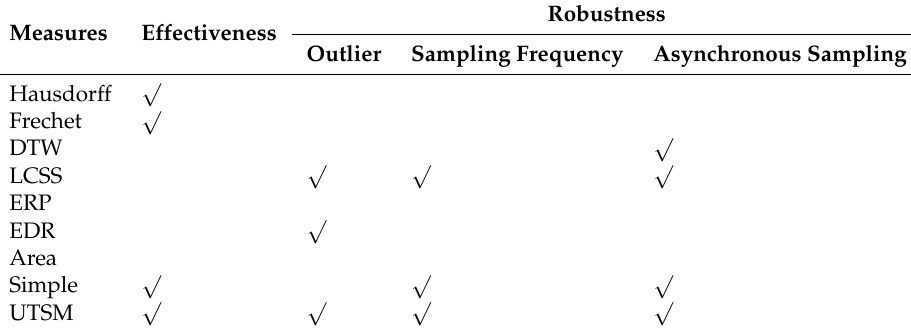
Table 3. Performance of different